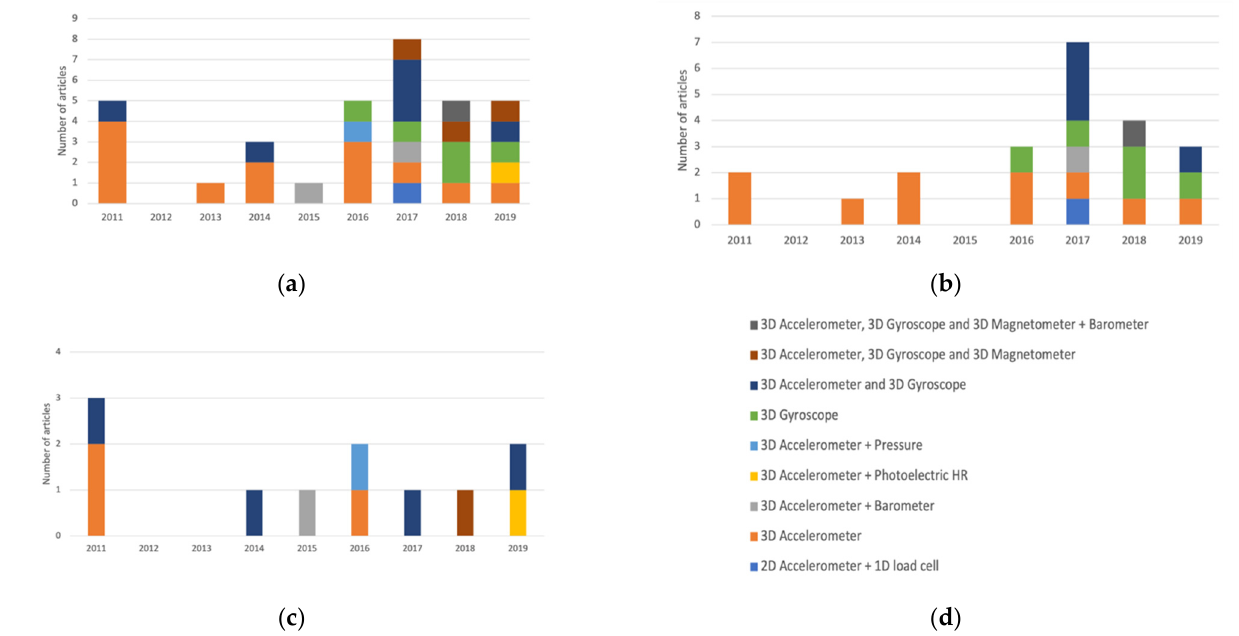
Figure A1. Information on number of articles using different types of sensors per publication year for: ( a ) all articles; ( b ) articles in Table 4; ( c ) articles in Tables 5 and 6; and ( d ) the sensor types. HR = heart rate. Please note that HR is used for heart rate only in this figure.